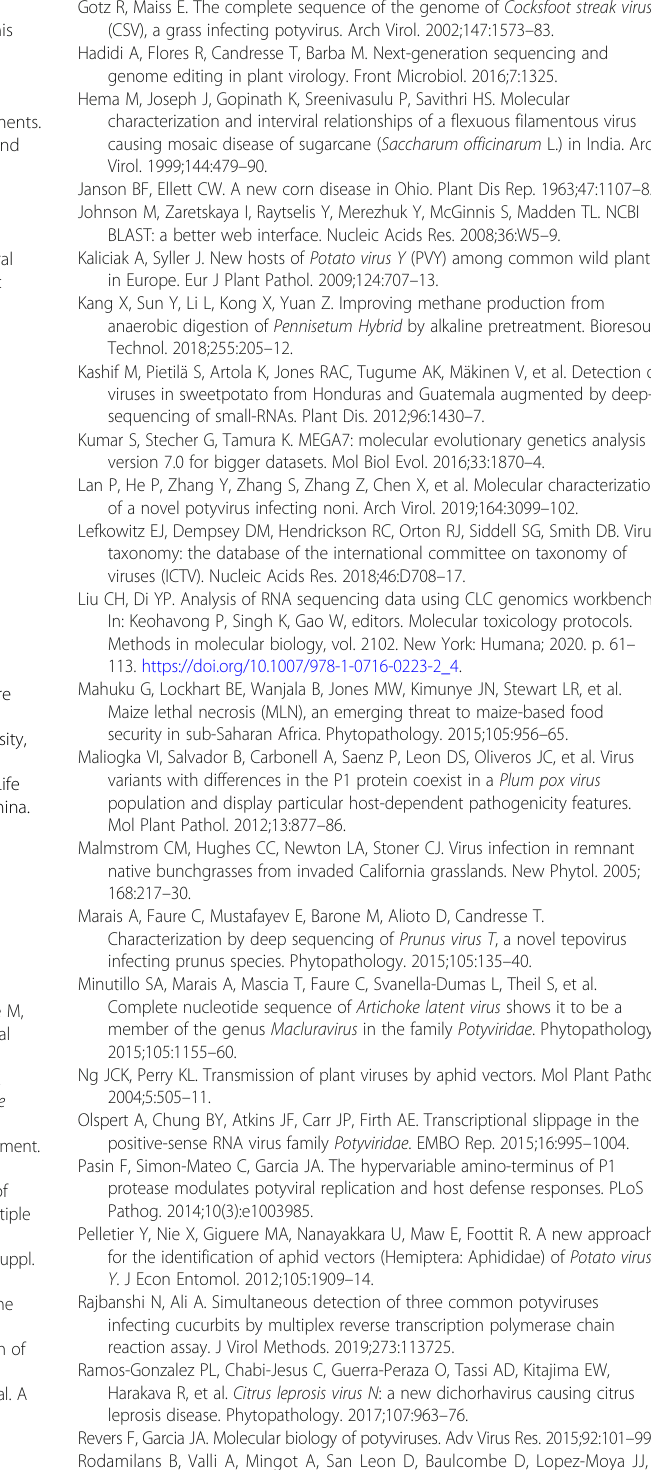
Additional file 2: Table S1. Primers used in this study. Table S2. The accession numbers of the potyviruses for sequence comparisons and phylogenetic analyses from NCBI